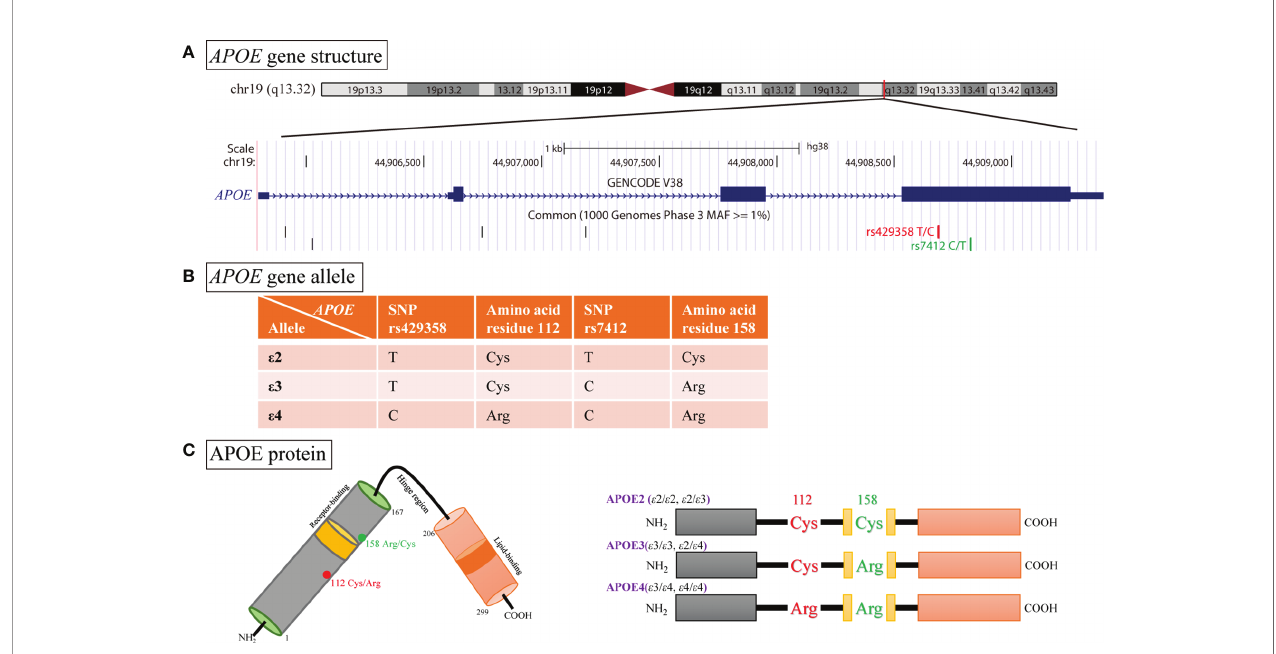
FIGURE 1 | Schematic illustration of APOE genotype and APOE isoform. (A) Functional single nucleotide polymorphisms (SNPs) in the APOE gene viewed in UCSC genome browser. (B) Two SNPs (rs429358 and rs7412) in exon 4 of APOE generate three major allelic variants ( ϵ 2, ϵ 3, and ϵ 4). (C) APOE protein is a polypeptide chain with 299 amino, and the APOE2, APOE3, and APOE4 isoforms differ from one another at amino acid residues 112 or